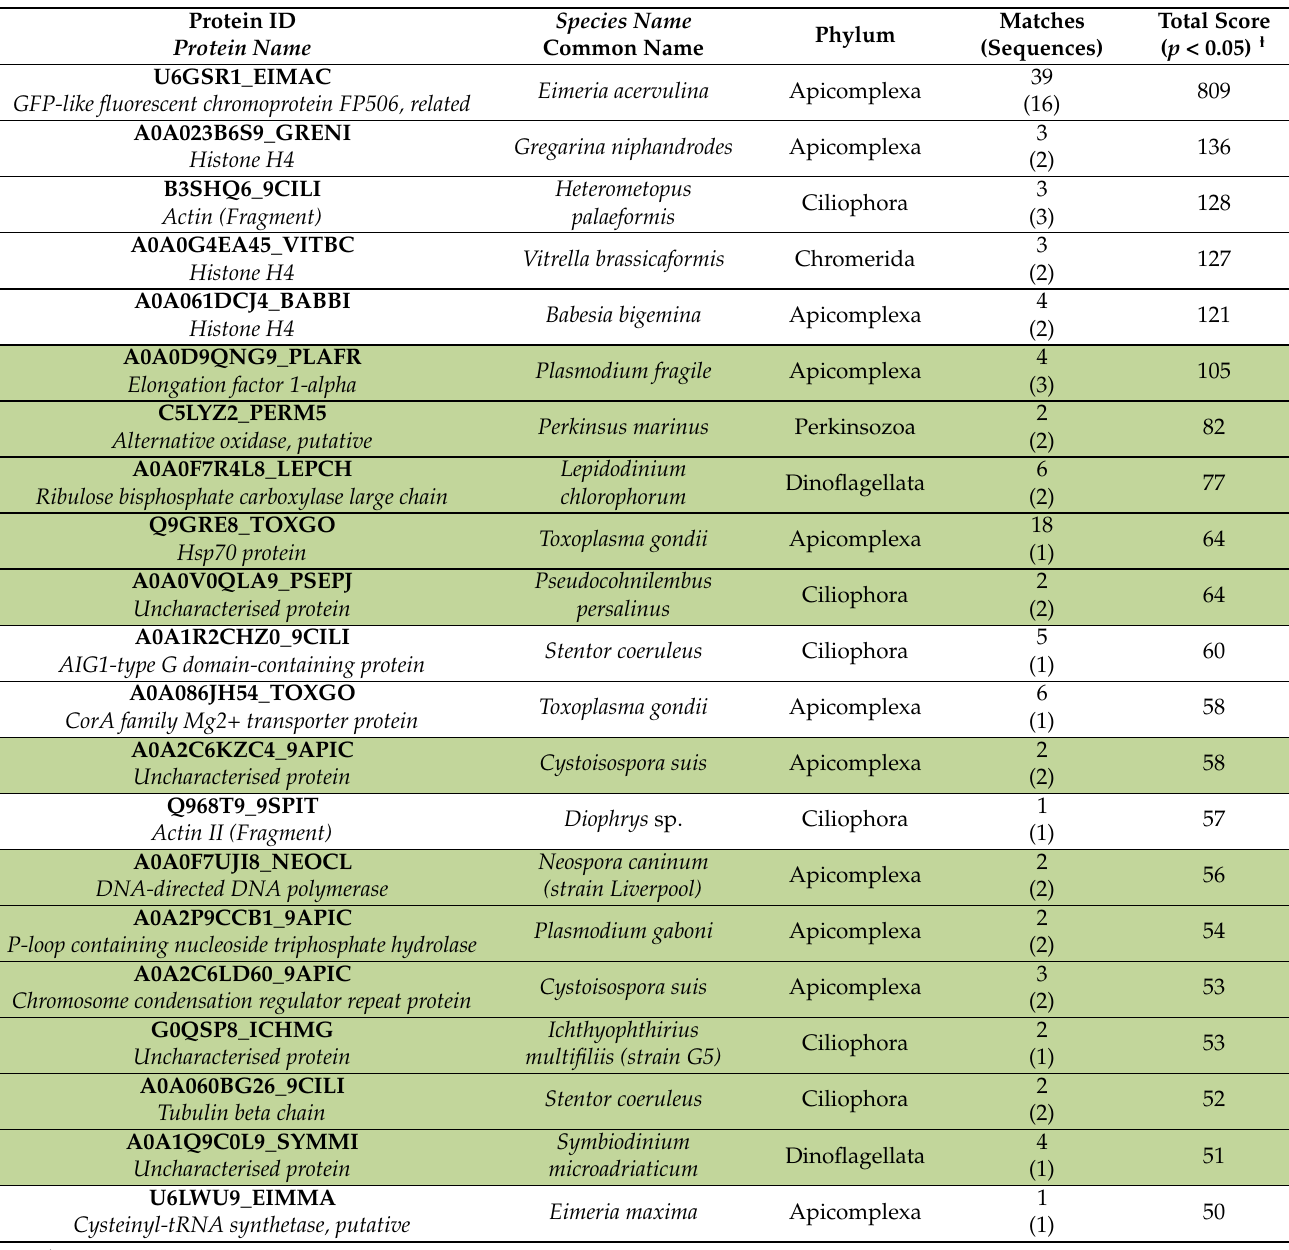
Table 2. Deiminated proteins in Merocystis kathae , as identified by F95-enrichment in conjunction with LC-MS/MS analysis. Deiminated proteins were isolated by immunoprecipitation using the pandeimination F95 antibody. The resulting F95-enriched eluate was then analysed by LC-MS/MS and peak list files submitted to Mascot, using a common Alveolata database. Peptide sequence hits are listed, showing species-specific hits, number of sequences for protein hits and total score. Species hit names and phylum are indicated; a full list of protein sequence hits and peptides is further provided in Supplementary Table S2. Proteins highlighted in green were deimination candidate hits only identified in M. kathae , not in P. sociabile .